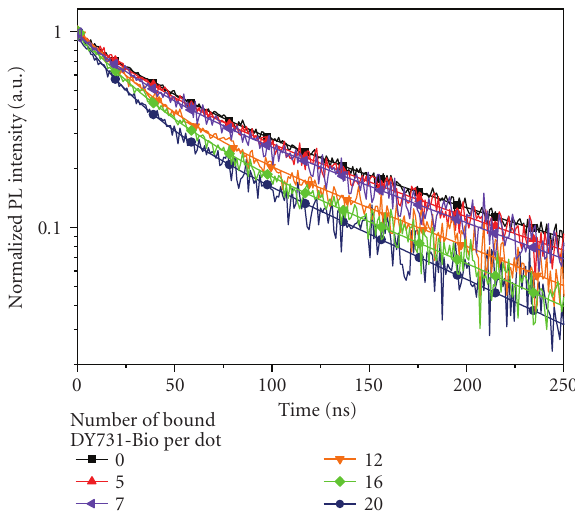
Figure 5: Photoluminescence decay of Qdot705-STV with increas- ing number of labelled DY731-Bio after